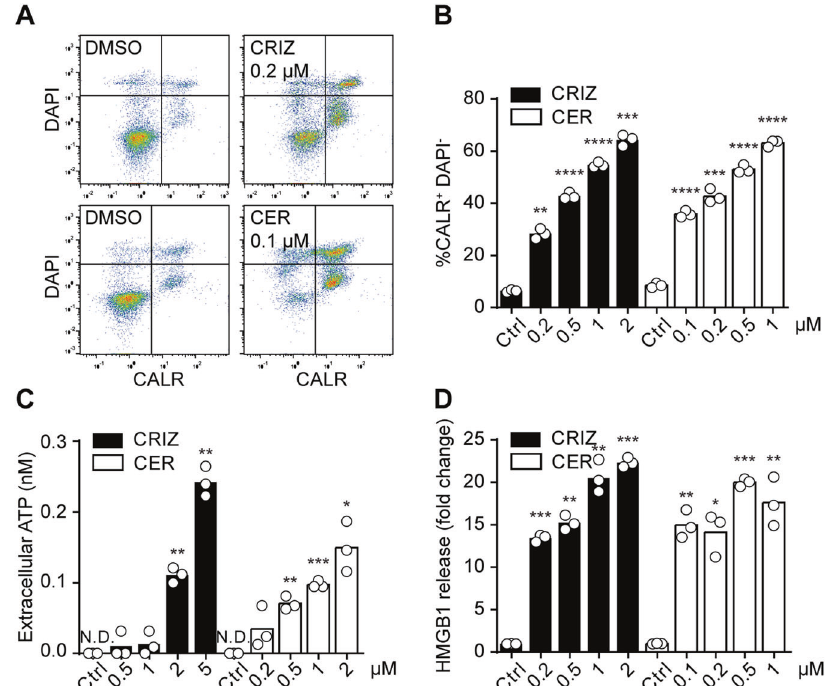
Fig. 4 Immunogenic cell death of murine ALK-positive cells. Murine NPM1-ALK + R80 cells were treated with increasing concentrations of crizotinib (CRIZ) or ceritinib (CER) for 6 h. Twenty hours later, exposed CALR was quanti fi ed on the surface of DAPI - cells by fl ow cytometry using an indirect fl uorescent staining. Representative dot plots are shown in A and percentage of CALR + DAPI - in B . ATP ( C ) or HMGB1 ( D ) released in the extracellular milieu of murine NPM1-ALK + R80 cells, treated with CRIZ or CER, were assessed using a luciferase-based assay or an ELISA after 6 or 24 h, respectively. Values of one representative experiment out of three are shown ( n = 3) ( A – D ). Statistical signi fi cance was calculated using the Student ’ s t test. * p < 0.05, ** p < 0.01, *** p < 0.001, **** p < 0.0001 vs. vehicle-treated cells. N.D.